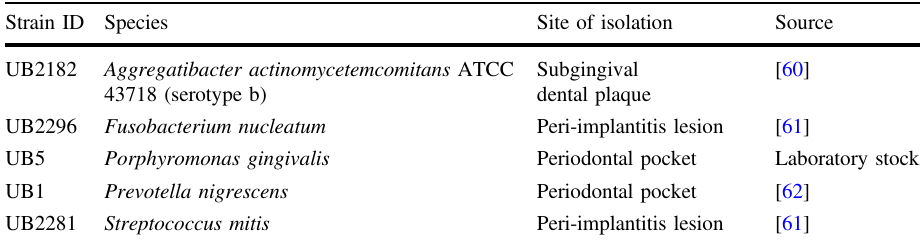
Table 1 Bacterial strains used in this